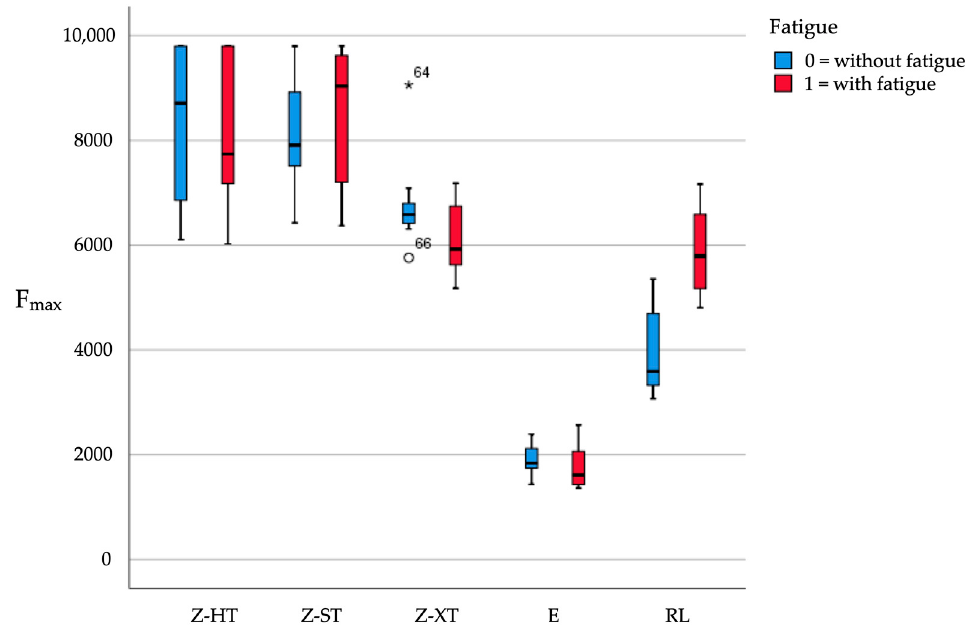
Figure 4. Boxplots of the failure load values (in N) of the tested groups (* indicates outlier for